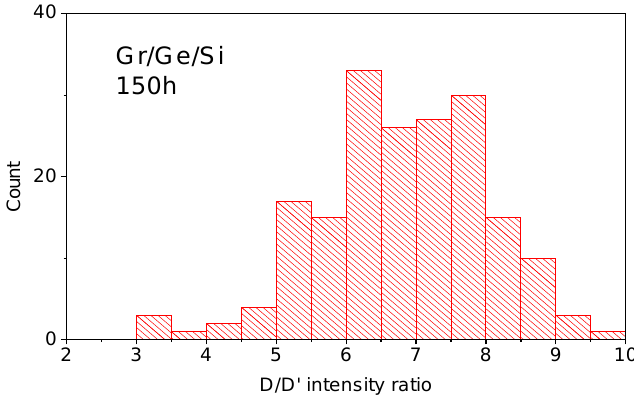
Figure 8. Histogram of the intensity ratio D/D’ for the Gr/Ge/Si sample after 150 h of water vapor treatment. The data come from the map of the Raman spectra taken in 150 points (“count” means the number of points for indicated range of the parameters D/D’).